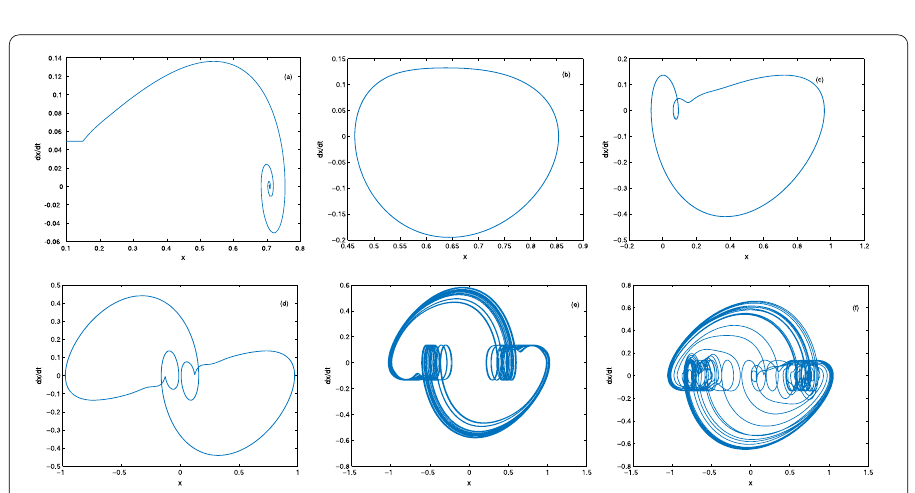
Figure 3 The phase plane plot in x – dx / dt space for different τ : ( a ) τ = 1 (stability), ( b ) τ = 1.8 (period-1), ( c ) τ = 2.6 (period-2), ( d ) τ = 2.7 (period-4), ( e ) τ = 3.1 (chaos), ( f ) τ = 3.3 (chaos) with parameter γ = 0.5